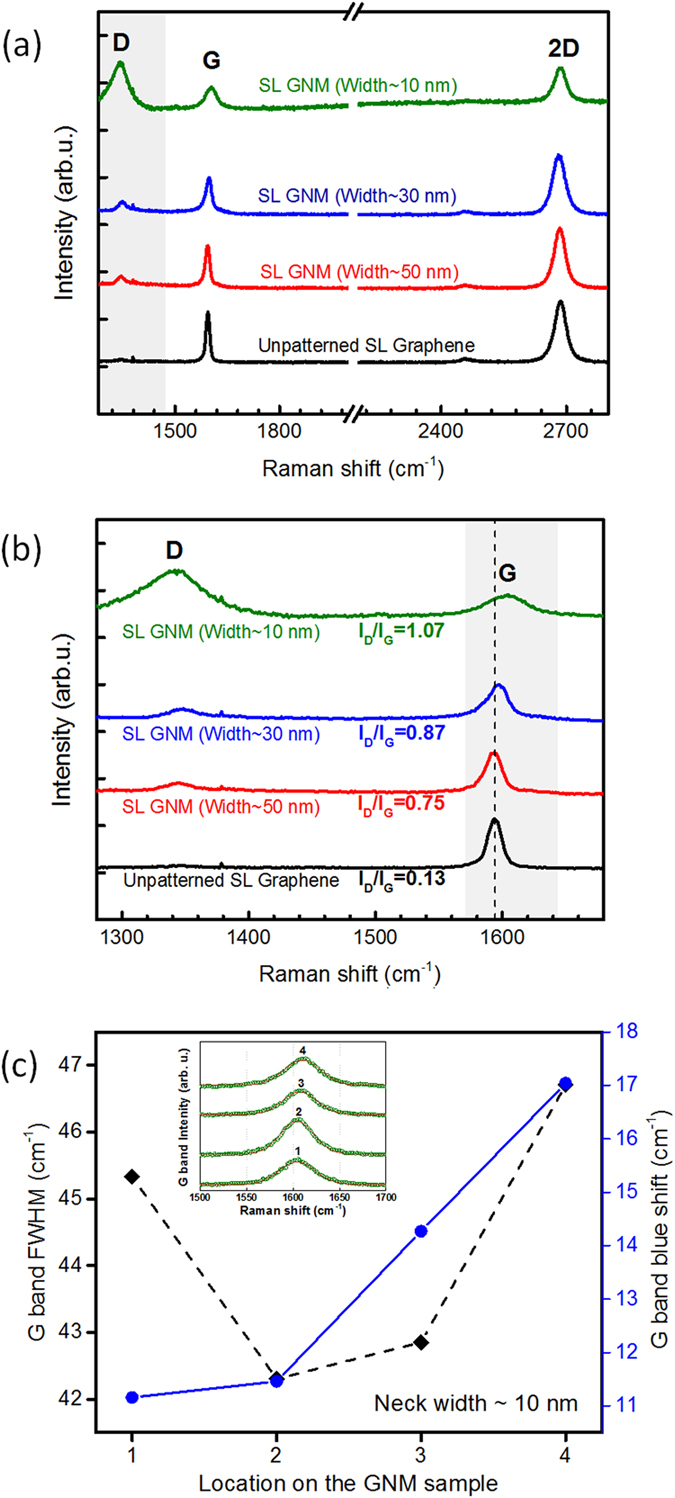
Raman Spectra of single-layer CVD GNM.(a) Raman spectra of the GNM films with different neck widths compared to pristine single-layer graphene. The spectra were offset for clarity. (b) Close-up view to the spectrum acquired from a showing the G and D bands for the mesh structures compared to the pristine graphene sheet. (c) Inset: G-band peaks acquired from four Raman scans on four different locations on the narrowest GNM sample. The intensity bands are fitted using Gaussian functions. The FWHM and blue shift of the G bands of the Raman spectra acquired from four different locations on the narrowest GNM sample. The G band FWHM is referred to as the left axis while the G band blue shift is referred to as the right axis. Inset shows the G band intensity of the spectra for those four locations.